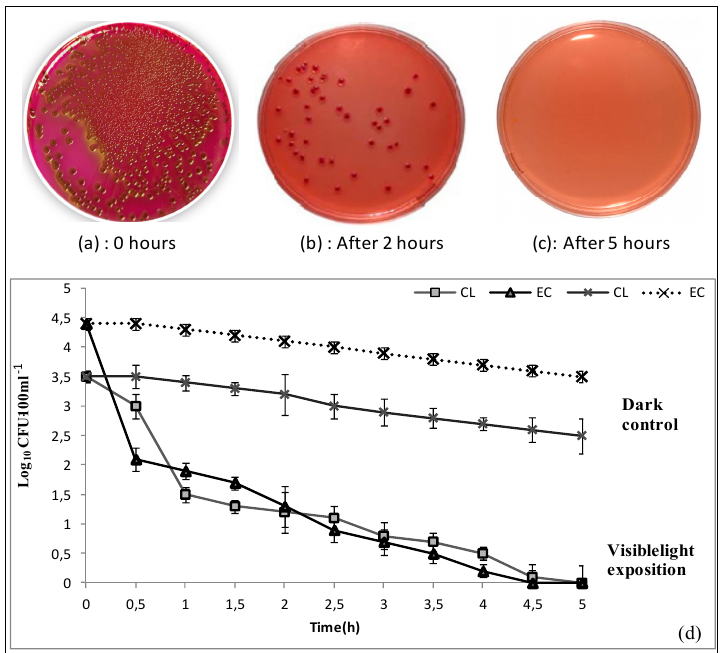
Figure 9. Images of E. coli colonies on a solid culture medium ( a ) before irradiation and after ( b ) 2 h and ( c ) 5 h irradiation in the presence of PAN/goethite nanofiber. ( d ) Evolution of bacterial inactivation by the natural nanocomposite fiber under continuous (column) treatment under visible light irradiation and in the dark (control). (Cl: Clostridium perfringens ; EC: E. coli ).